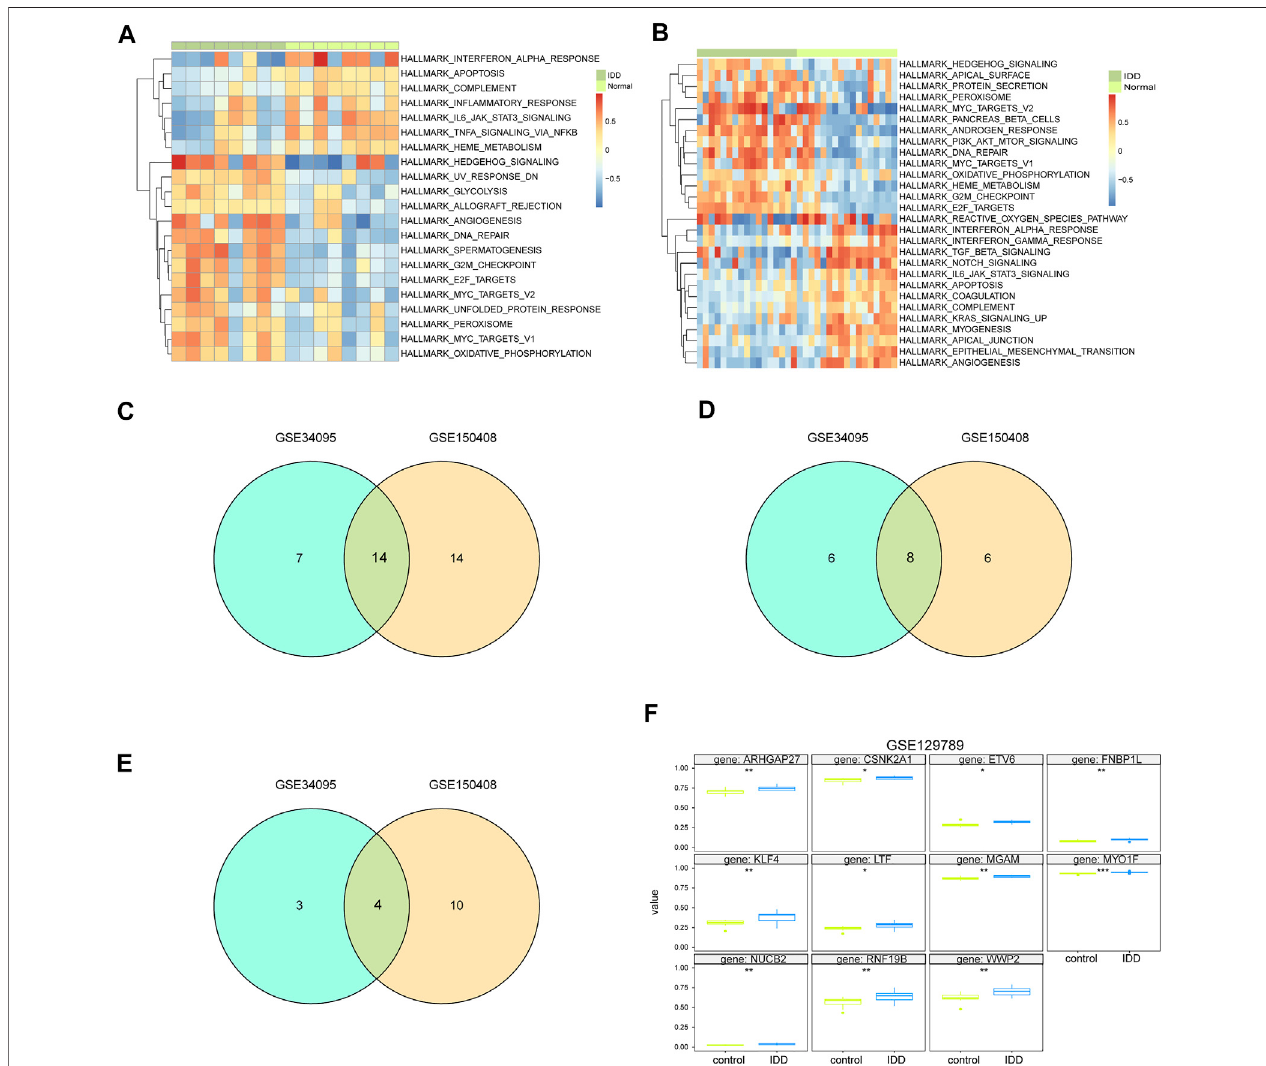
FIGURE 8 | GSVA analysis of hub genes. (A) GSVA analysis of mRNA dataset GSE124272 indicates 50 hallmark gene sets. (B) GSVA analysis of mRNA dataset GSE150408indicates50hallmarkgenesets. (C) Venndiagramofhallmarkforsigni fi cantdifferencesinnormaldisctissueanddisc-degeneratedtissuefromGSE124272 andGSE150408GSVAanalyses. (D) VenndiagramofhallmarkwithalowerenrichmentscoreinnormalintervertebraldisctissuethanthatinIDDtissuefromGSE124272 and GSE150408datasets. (E) Venndiagram ofhallmark withhigher enrichmentscoresinnormalintervertebraldisctissue thanthatinIDDtissue fromGSE124272 andGSE150408datasets. (F) Methylationlevelanalysisofhubgenes.Hubgeneswhosemethylationlevelsweresigni fi cantlydifferentinnormalintervertebraldisctissue and IDD tissue are shown.